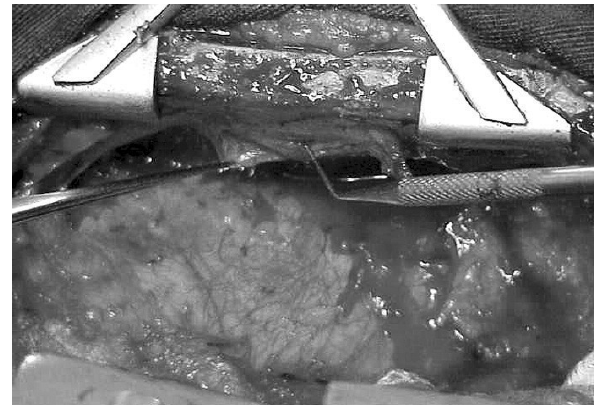
Fig.2 - Descolamento da artéria e exposição dos vasos intercostais com espátula fina (esculpidor) e pinça